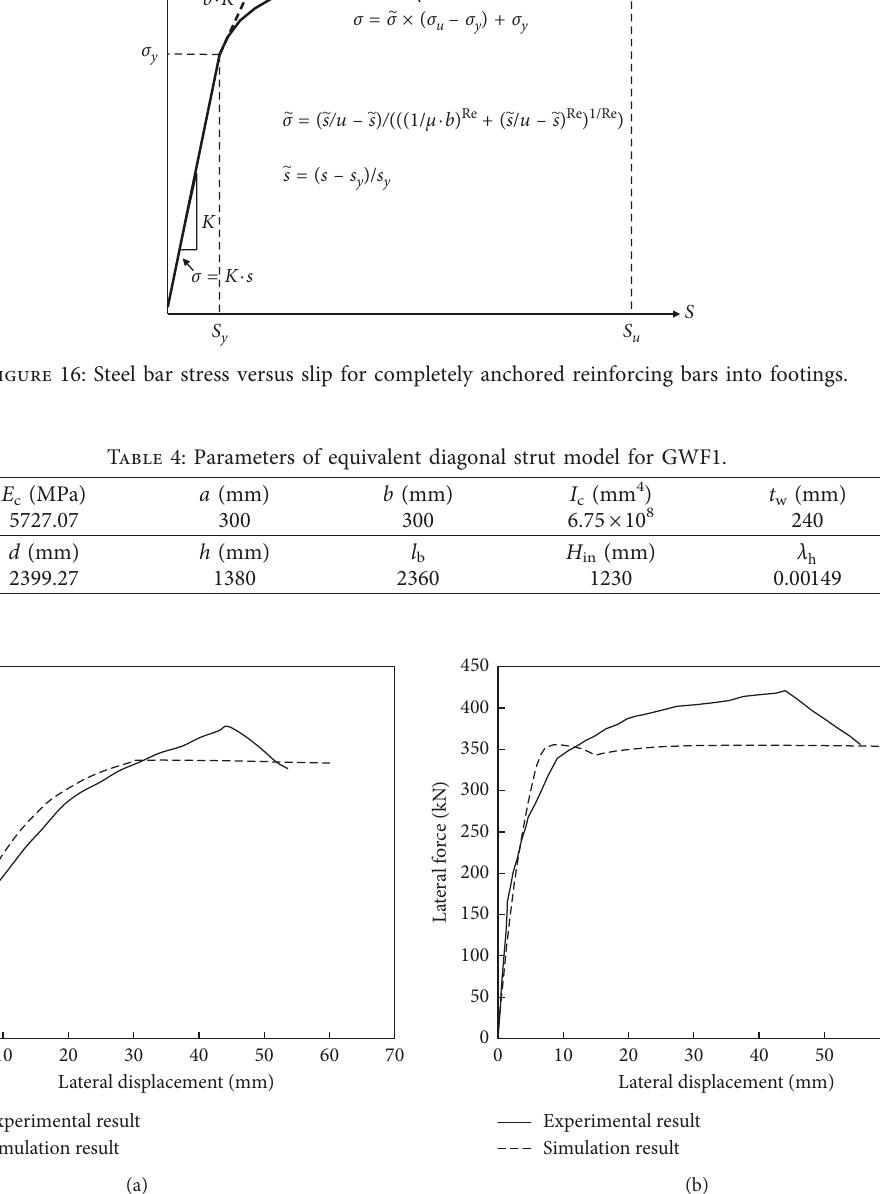
Figure 17: Comparison between pushover analysis results and experiment results: (a) PF; (b) GWF1.